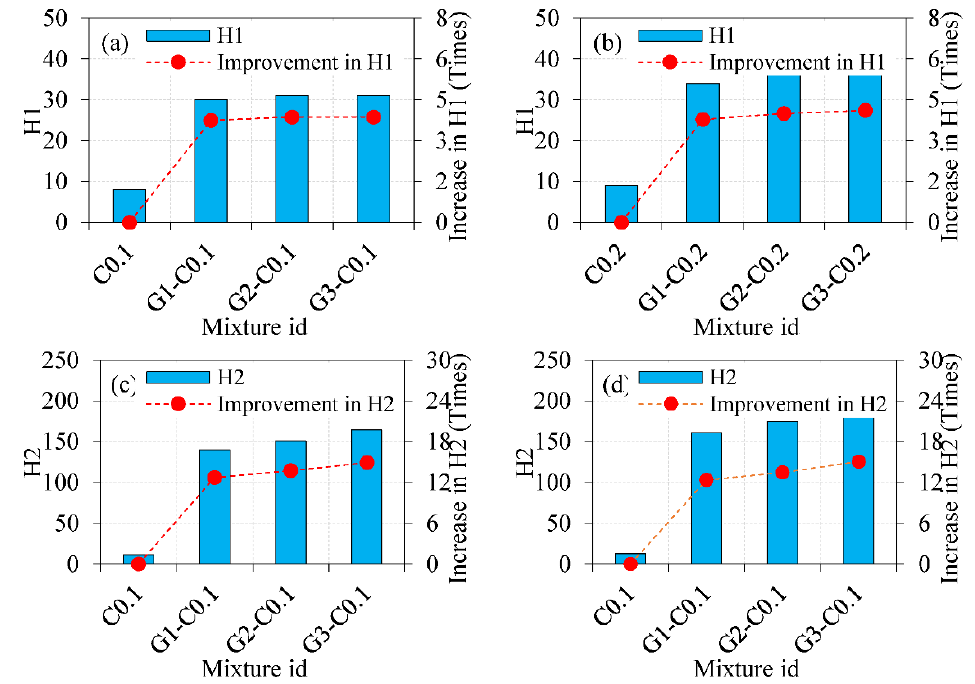
Figure 6. Initial cracking and failure impact numbers ( a ) H1 with 0.1% MWCNT, ( b ) H1 with 0.2% MWCNT, ( c ) H2 with 0.1% MWCNT, ( d ) H2 with 0.2% MWCNT.